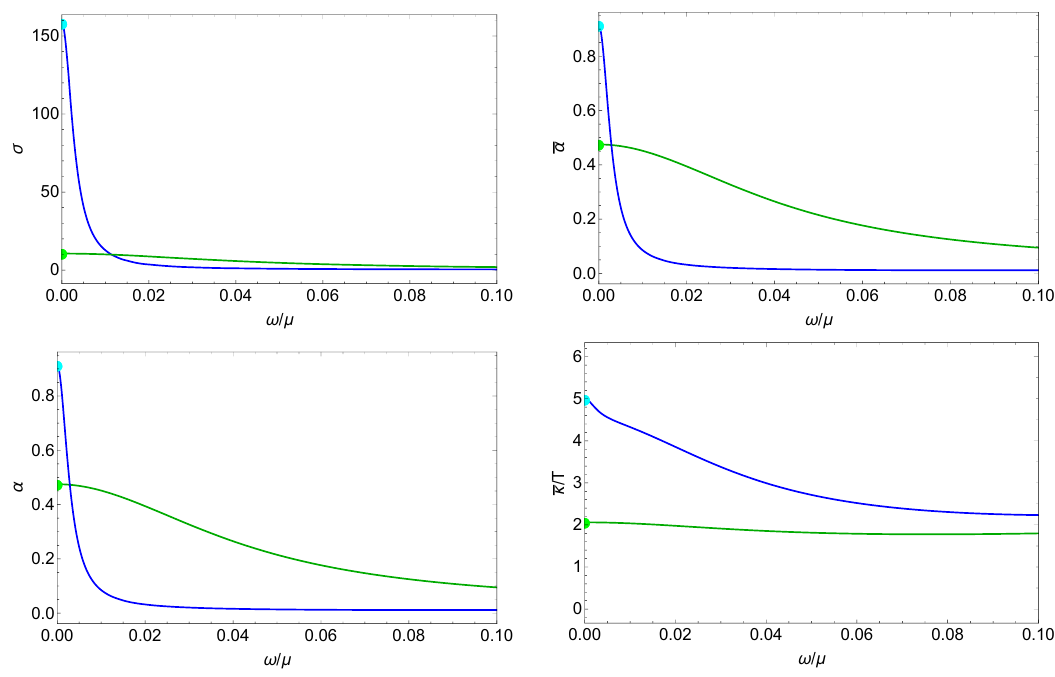
Figure 2 . Plot of the conductivity matrix as a function of the frequency for (cid:30) s = 0 and T=(cid:22) = 1 = 100 (blue) and T=(cid:22) = 4 = 100 (green). The dots at zero frequency represent the DC conductivities given in